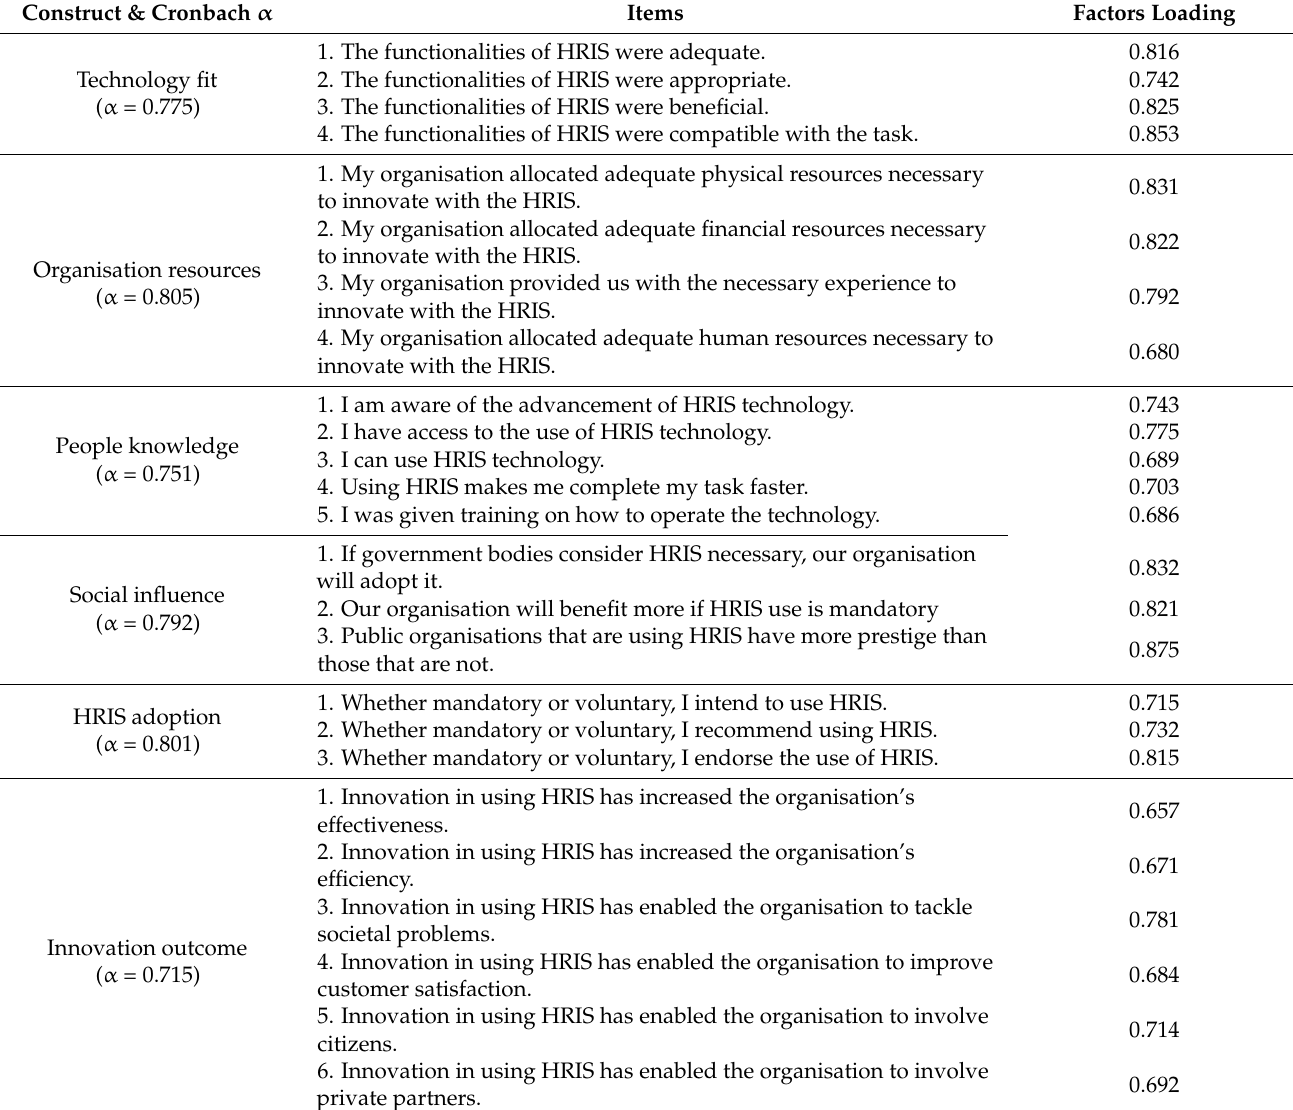
Table 2. Validity and reliability measurement.